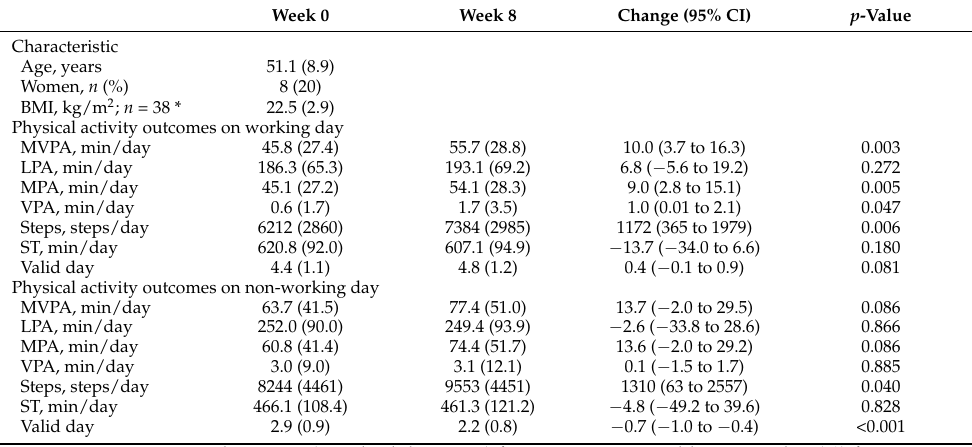
Table 3. Sub-domain analyses on working day and non-working day ( n = 40).